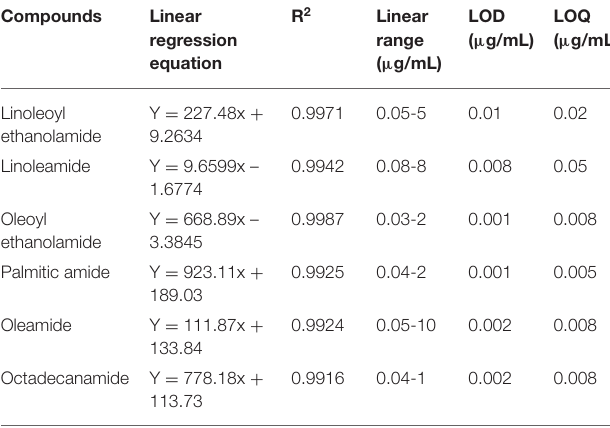
TABLE 2 | Linear regression equations, linear ranges, detection limits and quantitation limits of standard curves for six fatty acid amides. R 2 Linear Compounds Linear regression equation